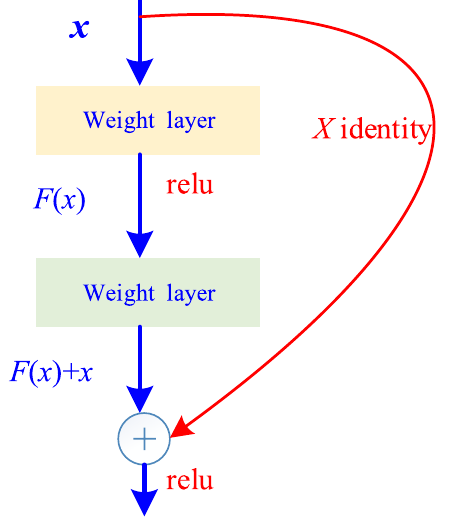
Fig. 4 The structure of the residual network